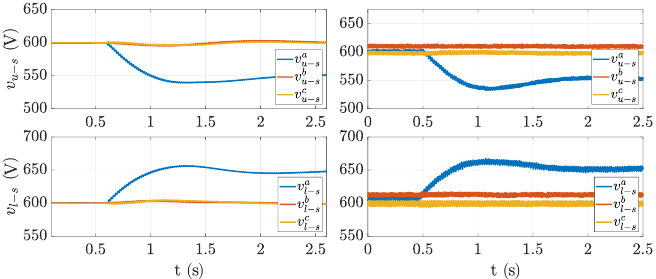
Figure 14. Simulation ( left ) and experimental ( right ) results, showing capacitors (arm cells) voltage during a step from 0 J (normal op.) to 60 J is applied to the energy difference between the upper and lower arms of phase